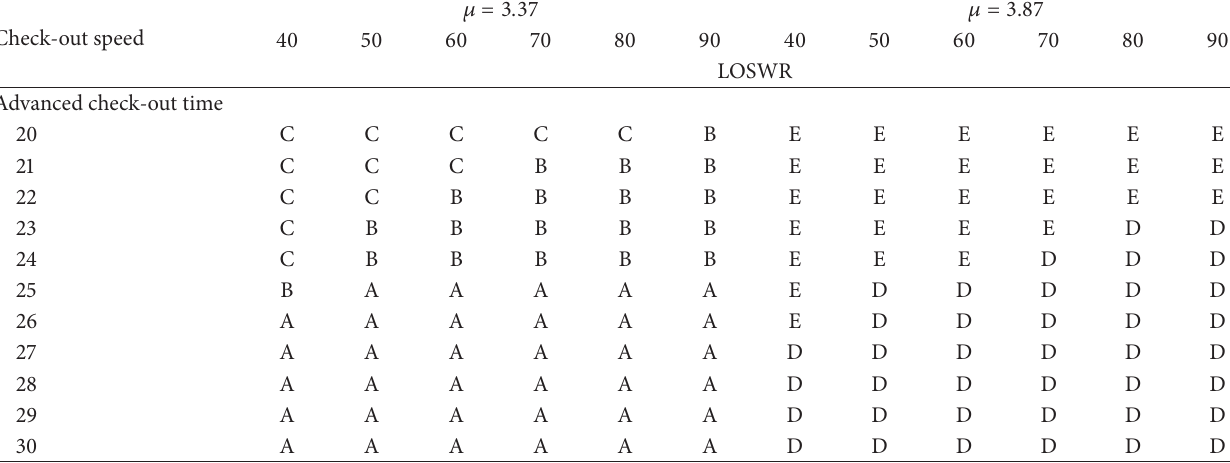
Table 9: The LOSWR varies over the values of 𝑡 𝑐 and V 𝑐 ( 𝜇 ).